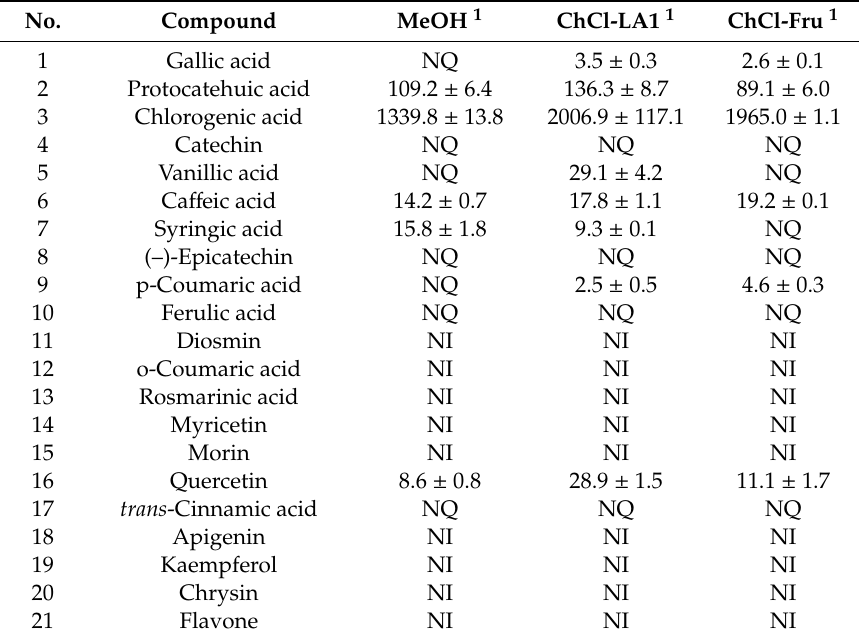
Table 4. Content of phenolic compound in real dried chokeberry samples. E ff ect of NADESs ChCl-LA1 and ChCl-Fru. Comparison of the results with those obtained with the traditional method using 80% aqueous